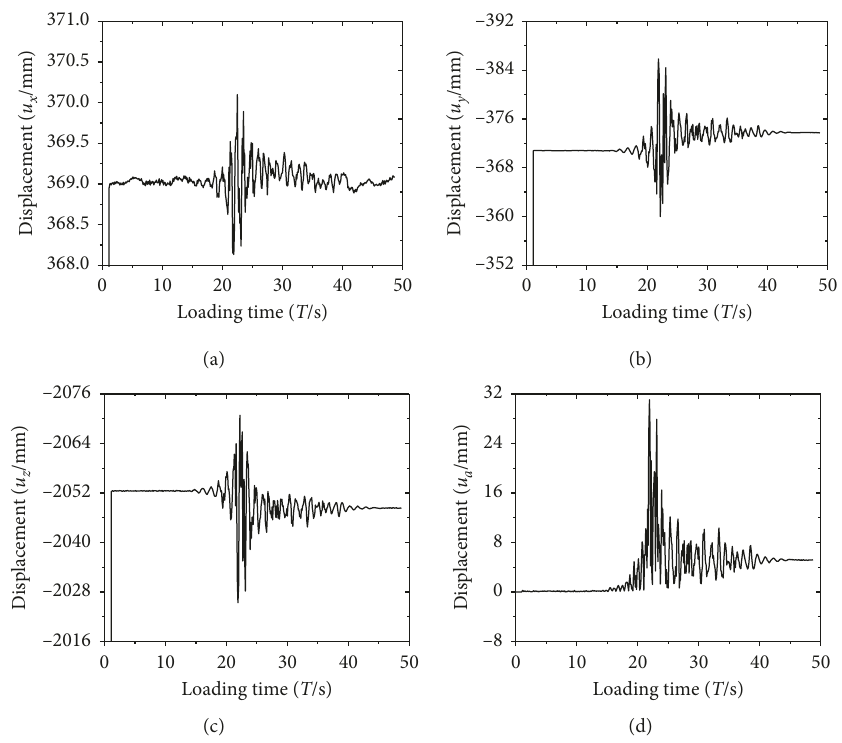
Figure 15: Variation of displacement with loading